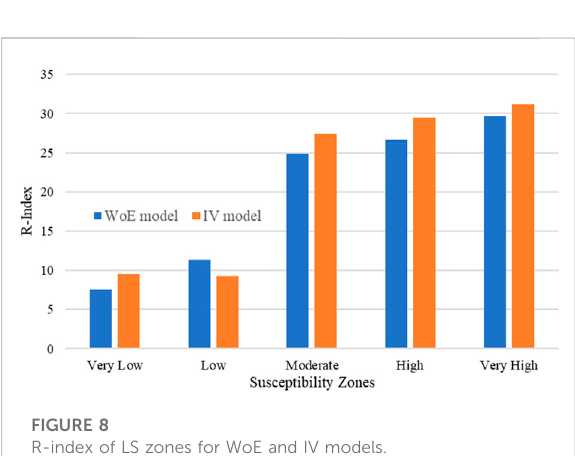
FIGURE 8 R-index of LS zones for WoE and IV